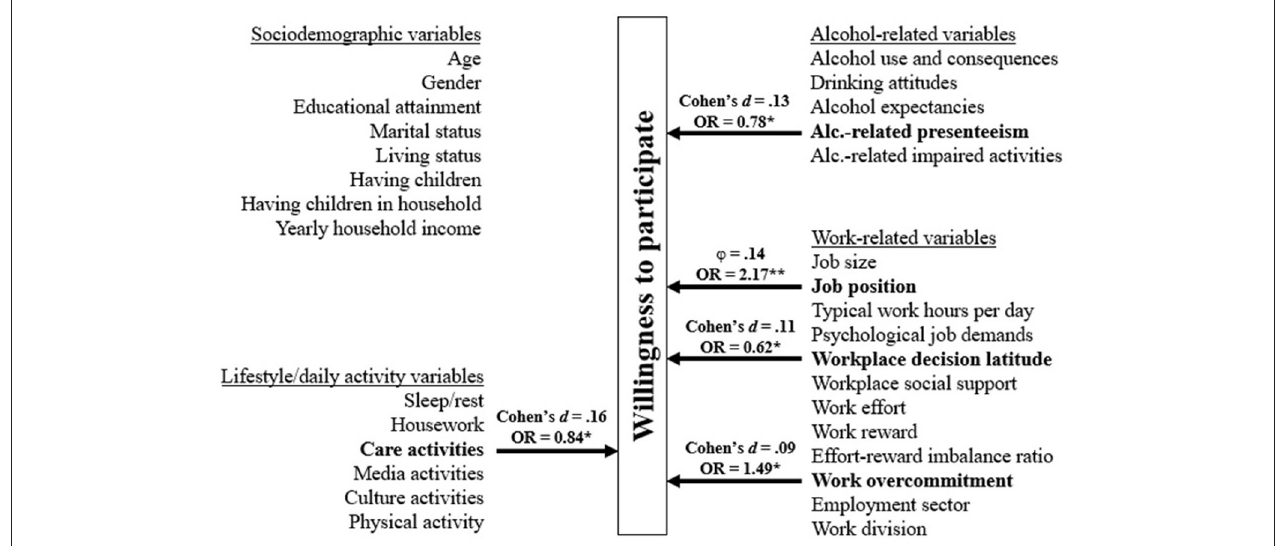
FIGURE 2 | Overview of correlates’ associations with willingness to participate in alcohol prevention interventions. The five correlates that demonstrated significant associations with willingness to participate in the adjusted analysis are presented in terms of both unadjusted and adjusted measures. φ = phi coefficient; * p < 0.05; ** p <